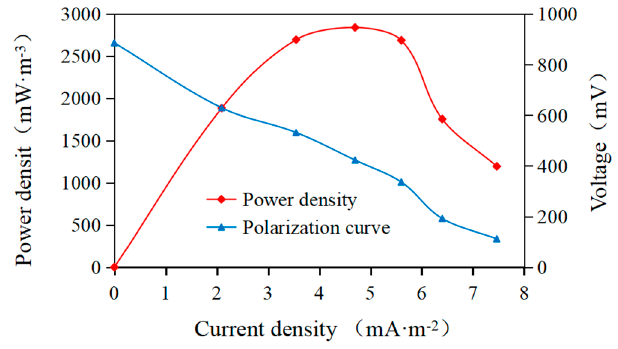
Figure 3. Power density curve and polarization curve of the AMDC.